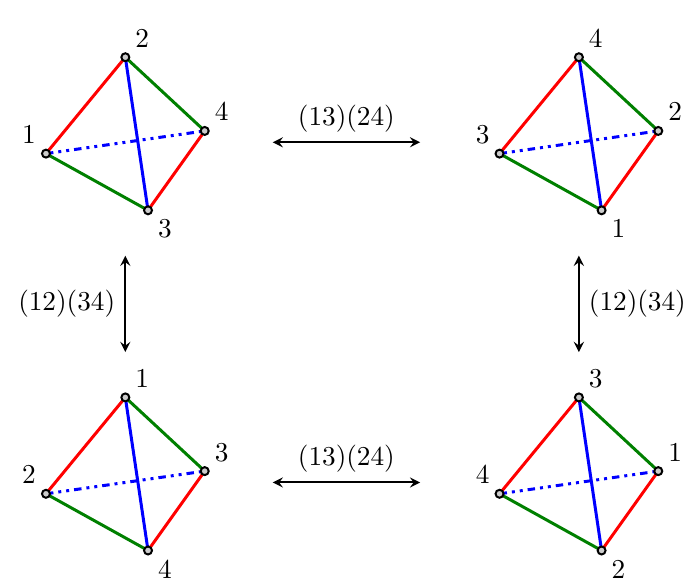
Figure 20. Symmetry of colored tetrahedron, Z 2 (cid:2) Z 2 . Each vertex represent the lattice index of fermion. (or, \color" in [40]) The colored edge corresponds to contraction of gauge indices. Each vertex should be connected to others via speci(cid:12)c color, which is actually equivalent to O ( N ) 6 gauge invariance.